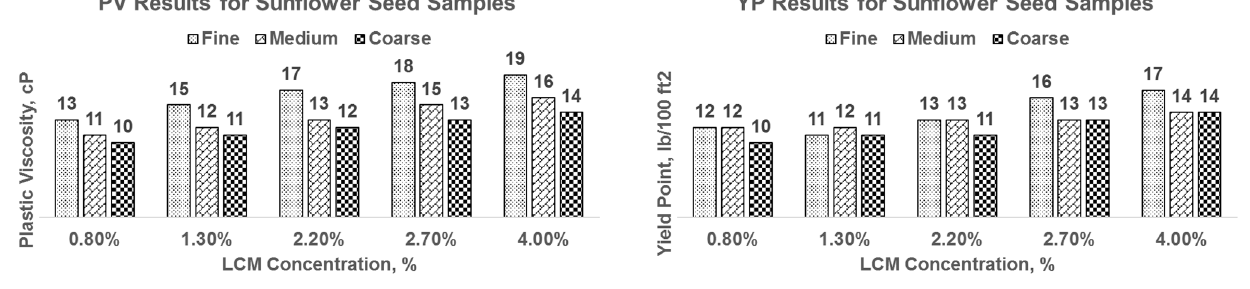
Fig. 4 Plastic viscosity results for sunflower seed